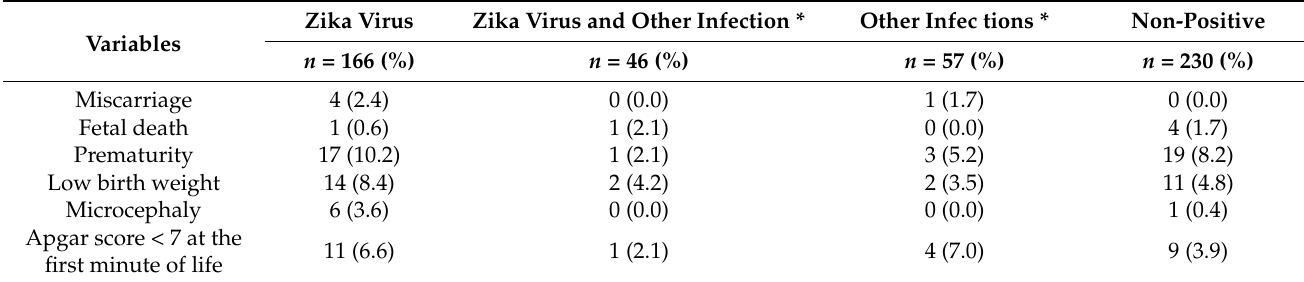
Table 1. Gestational outcome according to the infection status of pregnant women with exanthematic manifestation who sought care at the Foundation of Tropical Medicine Doctor Heitor Vieira Dourado, Manaus, Brazil. Variables